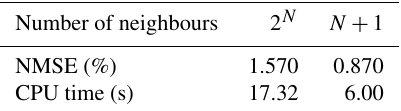
Table 2. Performance for the 5-D ( N = 5) case with p =